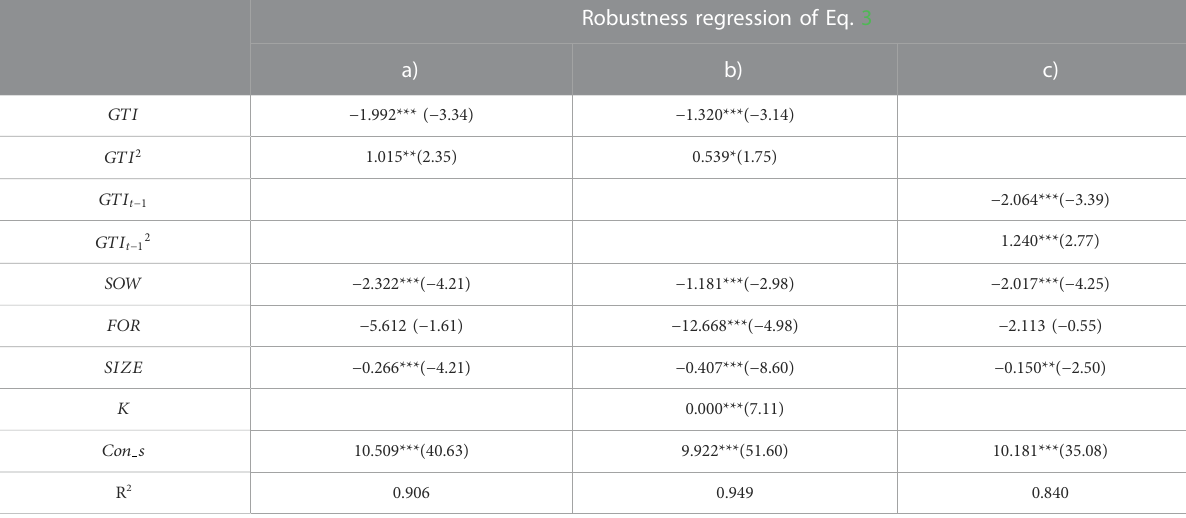
TABLE 5 Robustness regression results of green technology innovation and GVC